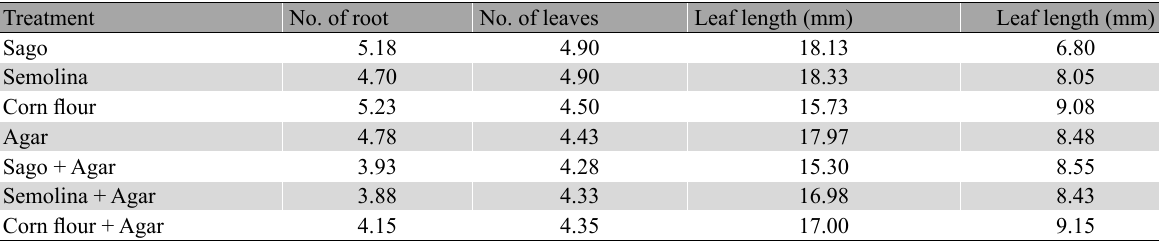
Table 7 . Effect of different gelling agent on growth parameters in KNC media Treatment No. of root No. of leaves Corn flour